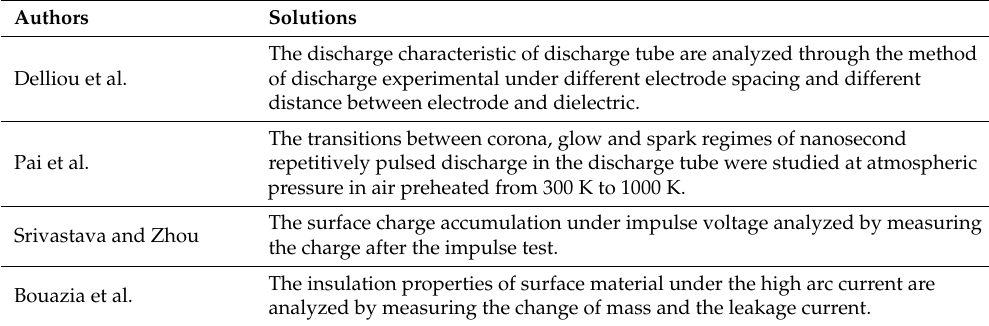
Table A1. The synthesis of the solutions proposed in the literature